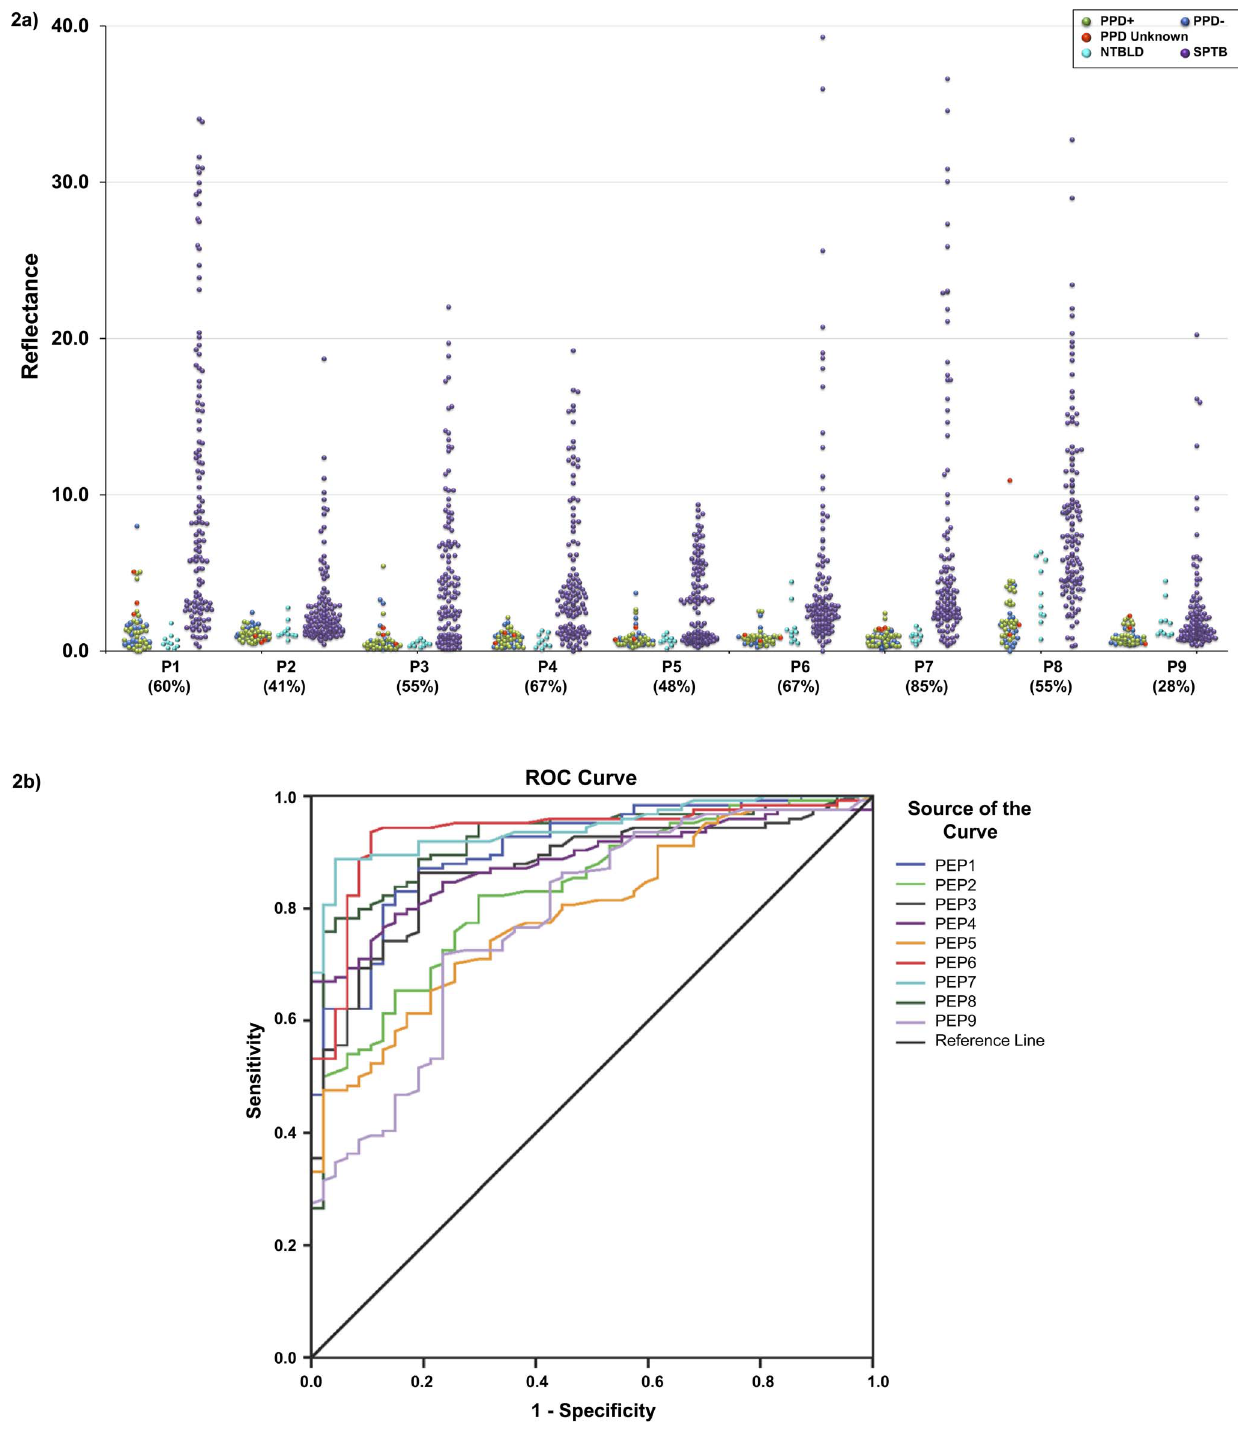
Figure 2. Reactivity of sera with individual BSA-peptide conjugates in lateral flow format. (A) Dot plot of reflectance values obtained with sera from healthy subjects [PPD- (blue), PPD + (light green), PPD unknown (red); n=47], non-TB lung disease patients [NTBLD (light blue); n=10], and sputum smear-positive TB patients [SPTB (purple); n=124, including 14 patients co-infected with HIV] tested for reactivity to BSA-peptide conjugates on lateral flow are plotted. Dashed lines indicate mean reflectance of the 47 healthy subjects plus 2.5 times the standard deviation which was used as cut-off to determine sensitivity in TB patients. Values in parenthesis under dot-plot for each BSA-peptide represent percent sensitivity of anti-peptide antibody detection obtained in TB patients with that peptide. The difference between healthy controls and TB patients was highly statistically significant (P , 0.0001) for all 9 peptides. The P values for difference between the NTBLD and TB patients ranged from 0.0073 2, 0.0001 for P1-P8; for P9 the P value was 0.7221. (B) ROC curves representing the performance of the 9 BSA-peptide conjugates (P1–P9) on lateral flow format for reactivity with sera from healthy subjects and smear-positive TB patients.